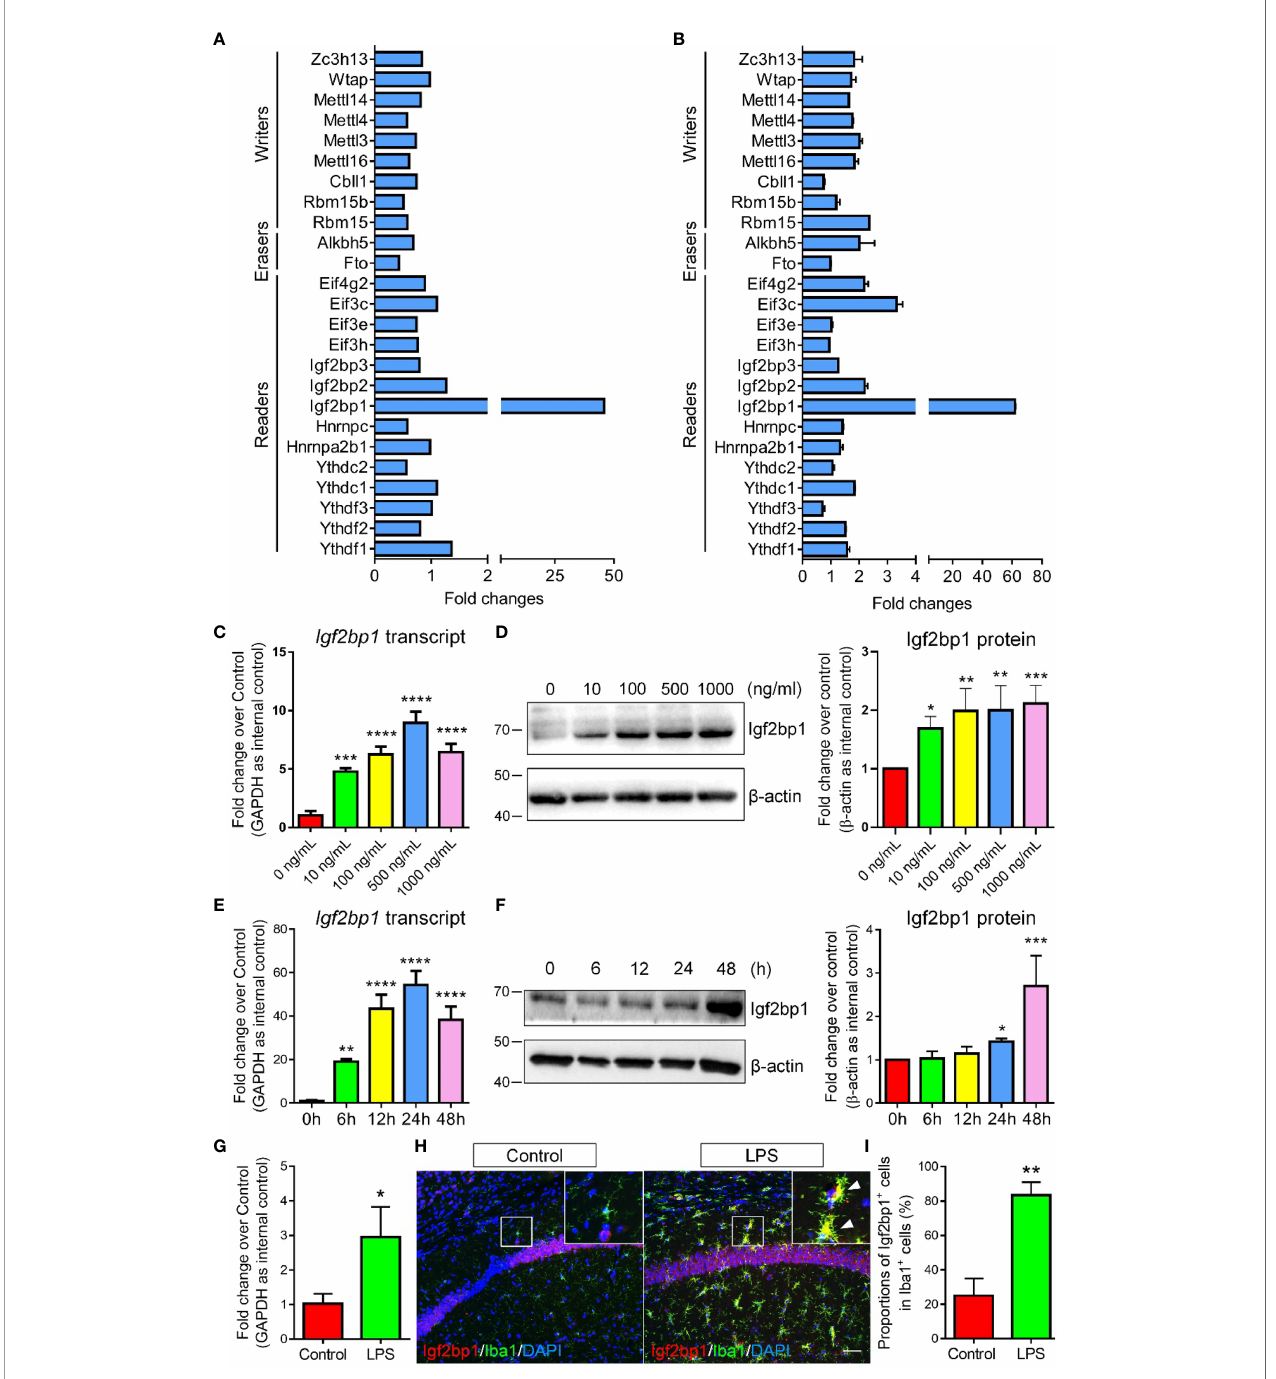
FIGURE 2 | Igf2bp1 expression is induced by LPS treatment. (A) RNA-seq results showing the expression patterns of m6A modi fi ers. (B) qRT-PCR results showing the expression patterns of m6A modi fi ers. (C) Igf2bp1 mRNA expression in microglia after LPS treatment at indicated doses. (D) Igf2bp1 protein expression in microglia after LPS treatment at indicated doses. (E) Igf2bp1 mRNA expression in microglia after LPS treatment at indicated time points. (F) Igf2bp1 protein expression in microglia after LPS treatment at indicated time points. (G) Igf2bp1 mRNA expression in mouse hippocampal tissues in control and LPS-injection groups. (H) Co-expression of Igf2bp1 and Iba1 in mouse hippocampal tissues in control and LPS-injection groups. Insets represent high-magni fi cation images of the corresponding small box area. Arrows point cells displaying Igf2bp1 and Iba1 immunoreactivities. (I) Quanti fi cation of the numbers of Igf2bp1 + cells in Iba1 + activated microglia in (H) . Scale bar: 50 m m. Data were represented as mean ± s.d. from three independent experiments. *, **, ***, and **** denote p < 0.05, p < 0.01, p < 0.001, and p < 0.0001,